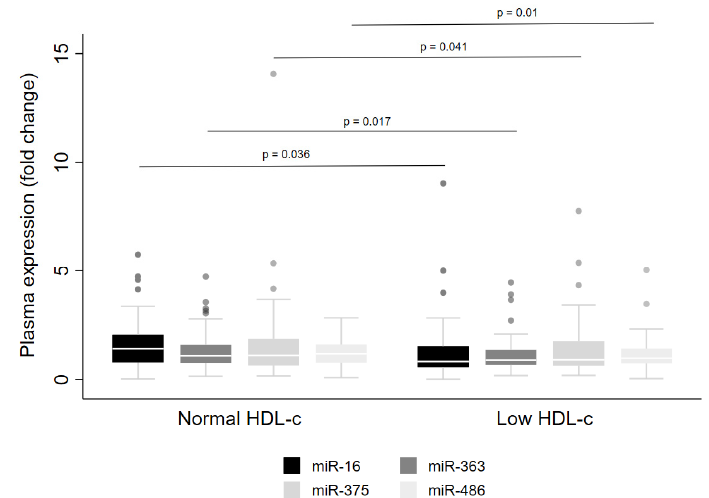
Figure 4. Levels of miRNA in plasma from adults with normal or low HDL-c concentrations. The sample sizes were as follows: miR-16, miR-375 and miR-486 (Normal HDL-c n = 92|Low HDL-c n = 100); miR-363 (Normal HDL-c n = 92|Low HDL-c n = 99). Comparisons between individuals with normal and low HDL-c for miRNA levels were conducted using the adjusted Wald test. The box plots depict the 25th–75th percentile, and the white line represents the median of each group. p < 0.05 indicates statistically significant differences.